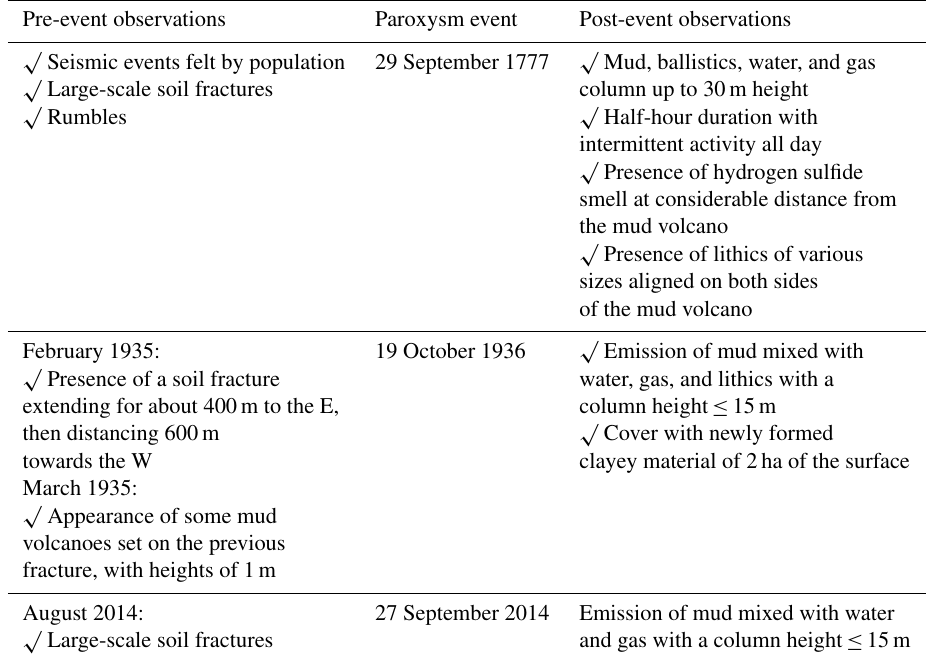
Table 2. Pre-event and post-event observation of the historical paroxysm events at